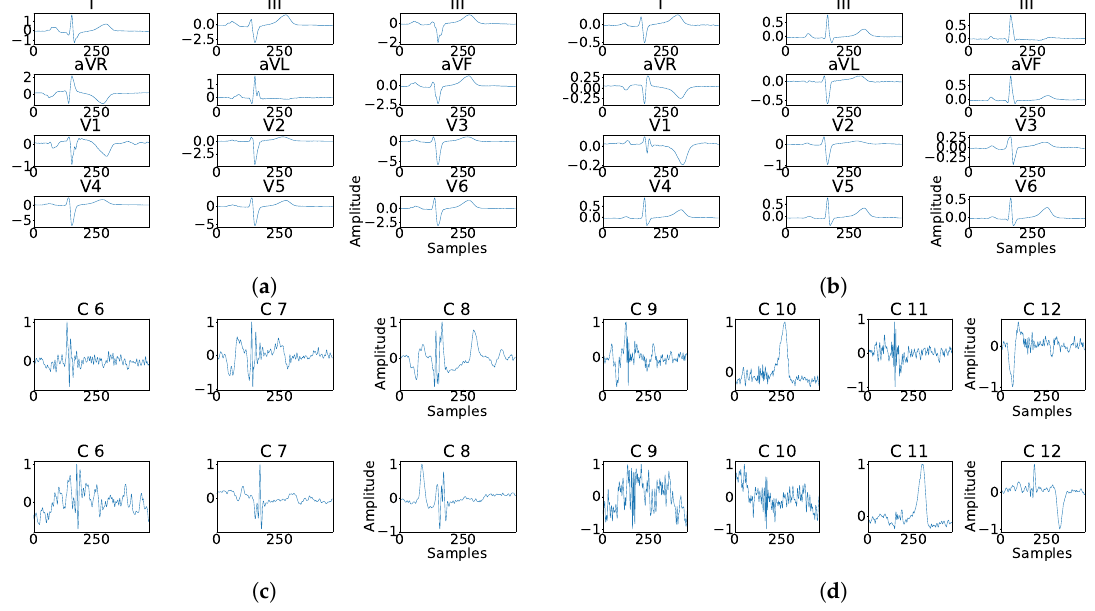
Figure 20. Example of fragmentation wave enhancement over real fragmented case. ( a ) Beat templates for each lead of real fragmented case, ( b ) beat templates for each lead of control case, ( c ) results of the best PCA method for the real fragmented case, in top subpanels and control case in bottom panels, and ( d ) results of the best ICA method for the real fragmented case, in top subpanels and control case in bottom